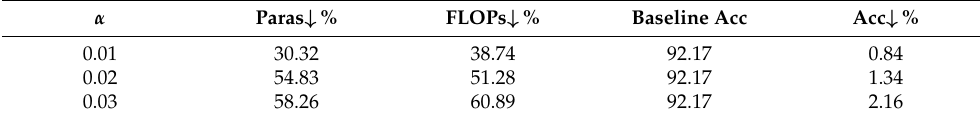
Figure 3. The effects of hyperparameter α on network pruning results. ( a ) ResNet-20; ( b ) ResNet-56. Table 6. Pruning results of ResNet-20 on CIFAR-10 when hyperparameter α is set to 0.01, 0.02 and